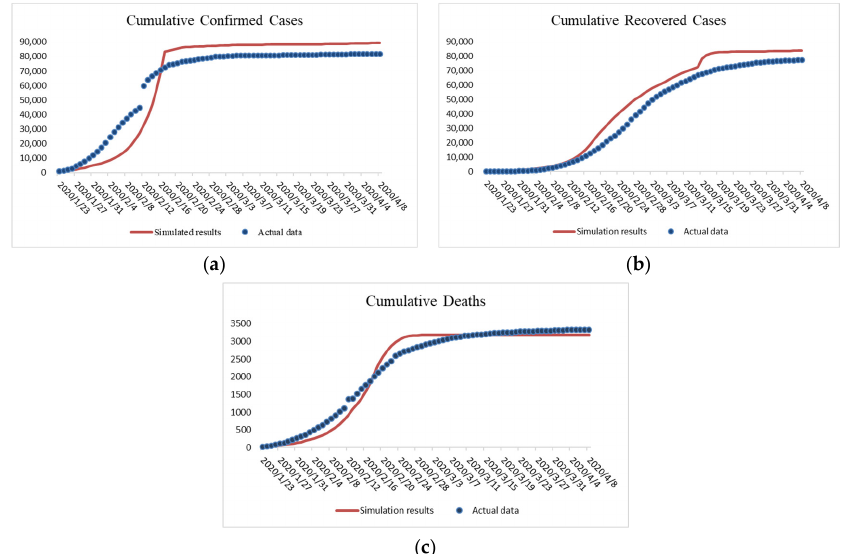
Figure 7. Epidemic cumulative cases simulation from 23 January 2020 to 8 April 2020. ( a ) Comparison of cumulative confirmed cases; ( b ) comparison of cumulative recovered cases; ( c ) comparison of cumulative deaths.